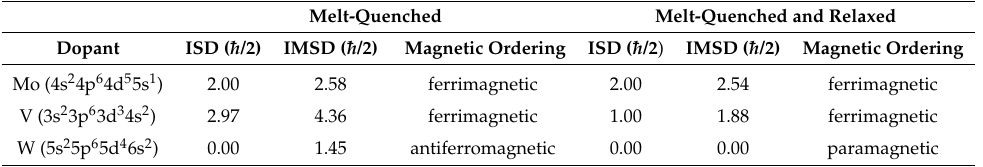
Table 2. Type of magnetic ordering of a-As 2 S 3 :TM